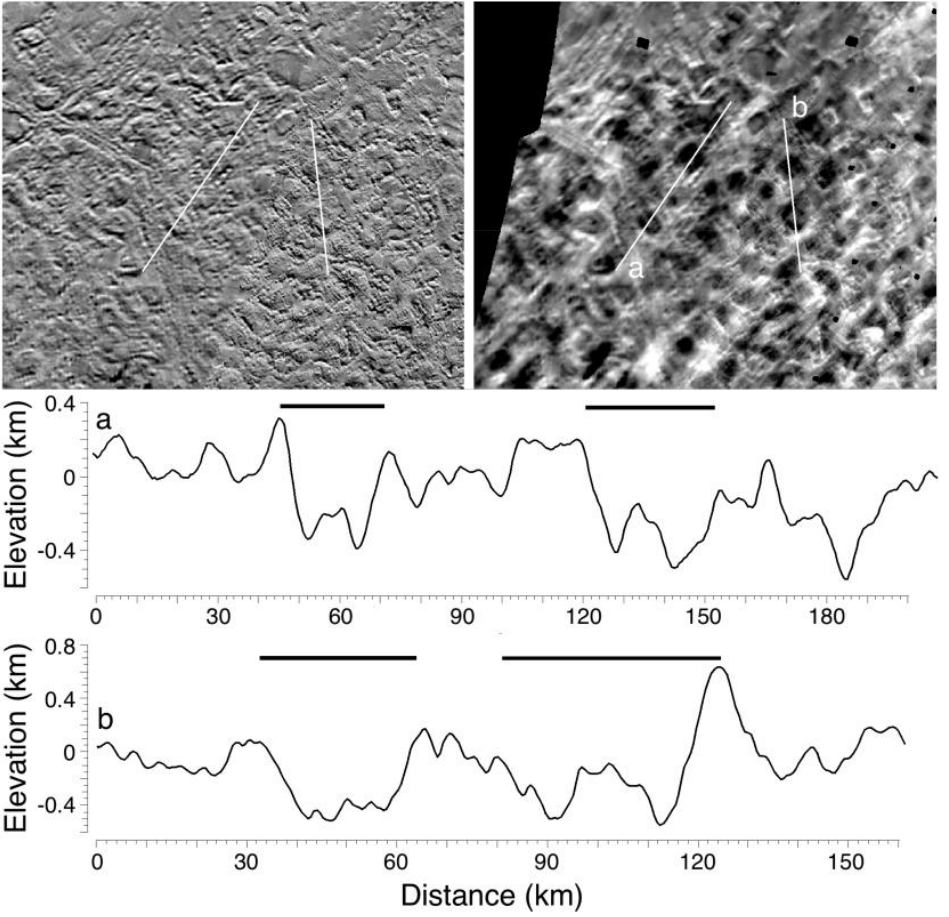
Figure 10. Topographic profiles across cantaloupe terrain from SG-PC-DEM in Figure 8. ( top ) Image mosaic and ( right ) DEM scene width is ~430 km. Note different horizontal scales in